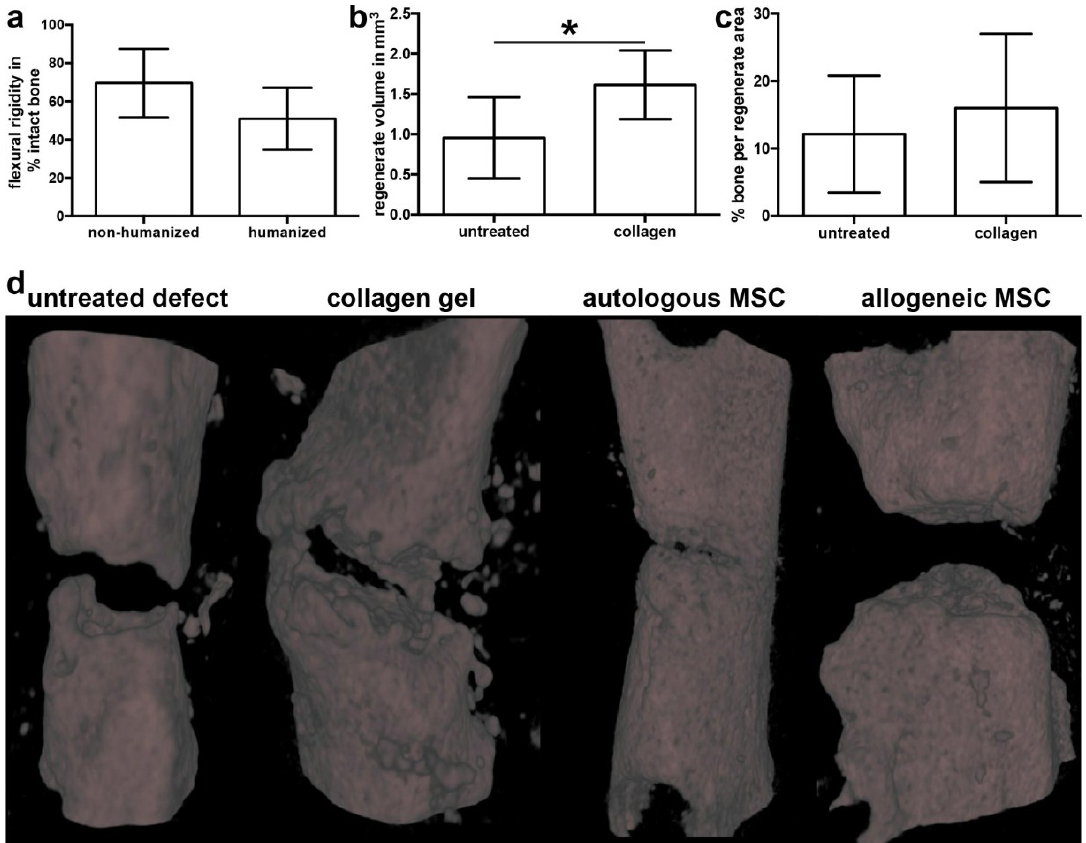
Figure 1. Validation of the defect model. ( a ) Stiffness (flexural rigidity) of healed osteotomies in non-humanized and humanized ( n = 6) NOD/scid-IL2Rγ cnull mice relative to the intact femur. ( b ) Volume of the regenerate in mice with untreated defects and defects treated with cell-free collagen assessed by micro-computed tomography (µCT). ( c ) Analysis of the bone fraction in the regenerate in untreated and collagen-filled defects by µCT. ( d ) Representative three-dimensional reconstructions of untreated defects and defects filled with cell-free collagen, collagen with autologous human mesenchymal stem cells (hMSC), or collagen with allogeneic hMSC. All analyses were performed on day 35 after surgery. The data are presented as the mean ± SD, * p ≤ 0.05. non-humanized; n = 8; humanized n = 6.